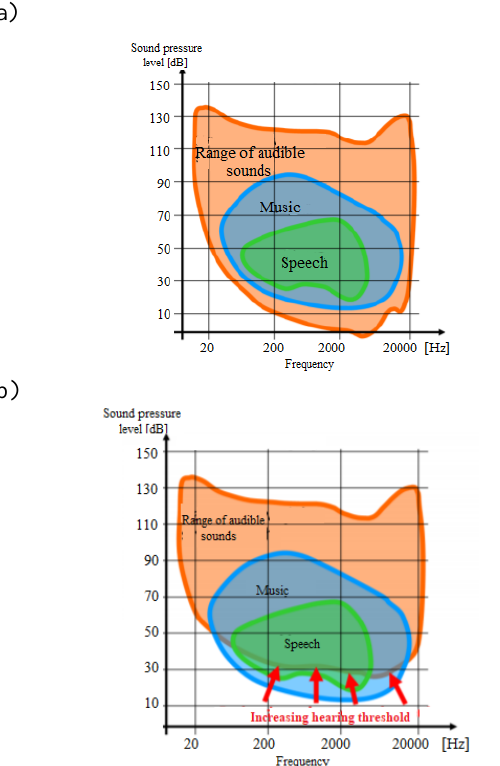
Fig. 1. The range of audible sounds, music and speech: a) a healthy person, b) a person with hearing impairment [24]